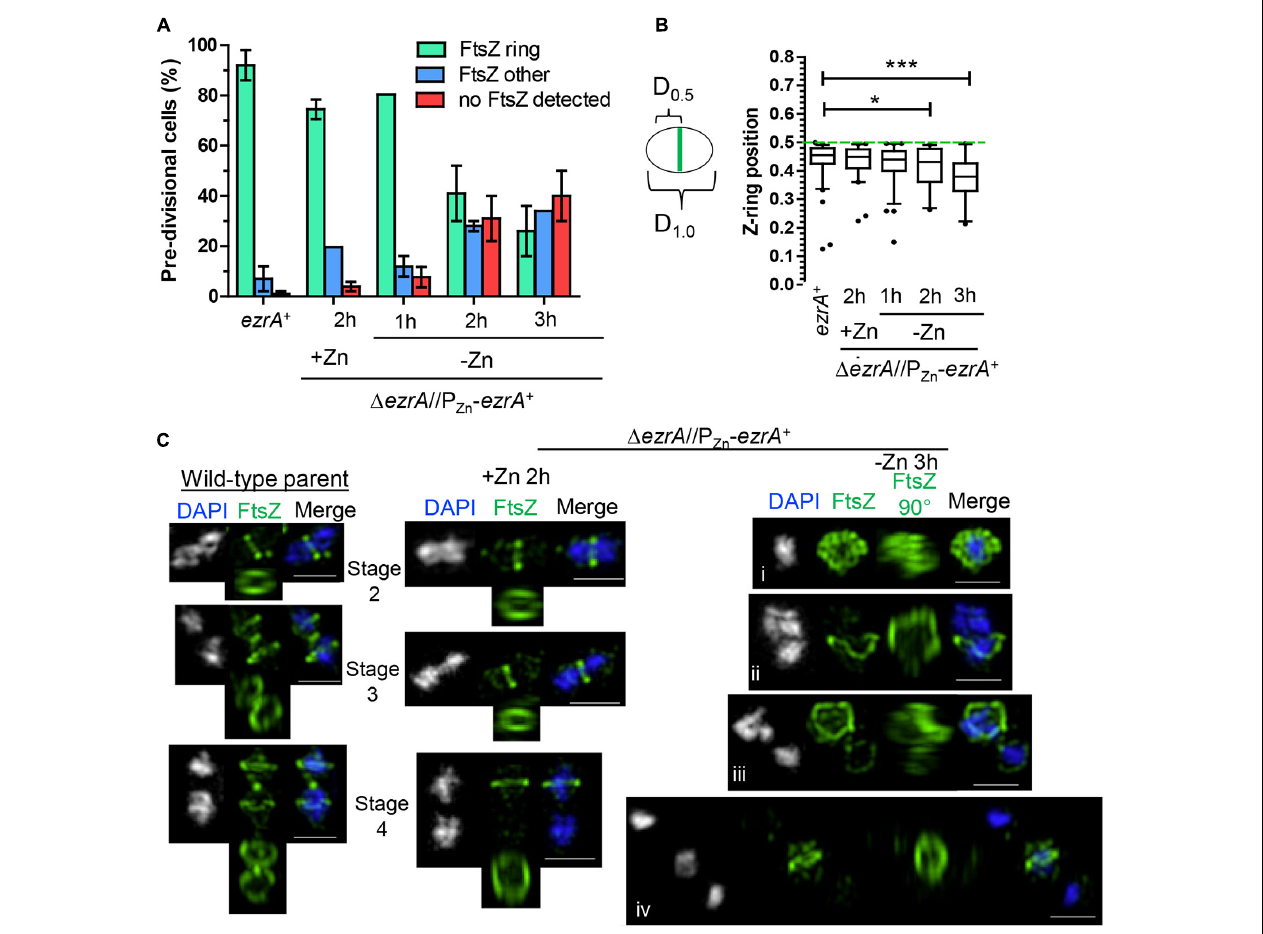
FIGURE 3 | EzrA depletion results in cells lacking Z-rings or aberrations in Z-ring positions. Wild-type (IU1945; ezrA + ) and ezrA depletion strain (IU8799+Zn; (cid:49) ezrA // bgaA ::P Zn - ezrA + ) were grown exponentially (+Zn; 0.5 mM ZnCl 2 and 0.05 mM MnSO 4 ), and IU8799 was depleted of EzrA by shifting cells to BHI broth lacking ZnCl 2 and MnSO 4 as described in Materials and Methods. EzrA depleted cells were obtained at appropriate time points, prepared for IFM, and analyzed. Native FtsZ proteins were detected via anti-FtsZ antibodies as described in Supplementary Table 5 . (A) Pre-divisional cells (stage 1) or post-divisional cells (daughters of stage 4) were binned into three different categories based on FtsZ localization events from 2D-EFm images. The bar is the mean percentage ± the SD for two separate IFM fields of one biological replicate. The different color bars represent cells that contained FtsZ-rings (green), FtsZ other (blue), or no FtsZ detected (red). The experiment was performed two independent times with similar results. (B) Box-and-whisker plots (whiskers, 5 and 95 percentile) of the FtsZ-ring position relative to whole cell length in cells which contained rings in (A) . The smaller distance of the Z-ring to the cell pole was measured and divided by the whole cell length to determine Z-ring position. Green dotted line indicates D = 0.5, a precisely midcell measured Z-ring. Data are from one biological replicate for a subset of cells that contained rings in (A) . ( ezrA + , n = 86 cells; +Zn 2 h, n = 65 cells; -Zn 1 h, n = 72 cells; -Zn 2 h, n = 35 cells; -Zn 3 h, n = 24 cells). p -values obtained with Mann–Whitney two-tailed unpaired t-test are for comparisons between ezrA + and other conditions. * and *** indicate p < 0.05 and < 0.001, respectively. (C) 3D-SIM examples of FtsZ-labeled cells shows EzrA-depletion leads to major aberrances in FtsZ-ring presence, FtsZ-ring placement, and FtsZ-structure. More than 20 cells were analyzed per condition (wild-type, (cid:49) ezrA //P Zn - ezrA + +Zn, (cid:49) ezrA //P Zn - ezrA + -Zn 3 h). Left panels show wild-type cells. Middle panel shows EzrA complemented cells. Further right panels show different aberrances in FtsZ structures during EzrA depletion, (i) FtsZ diffuse, (ii) FtsZ aberrant twisted rings, (iii) aberrant stage 4 like cells, (iv) two outer cells without labeling containing intense DAPI staining while the middle cell contains semi-diffuse DAPI and normal